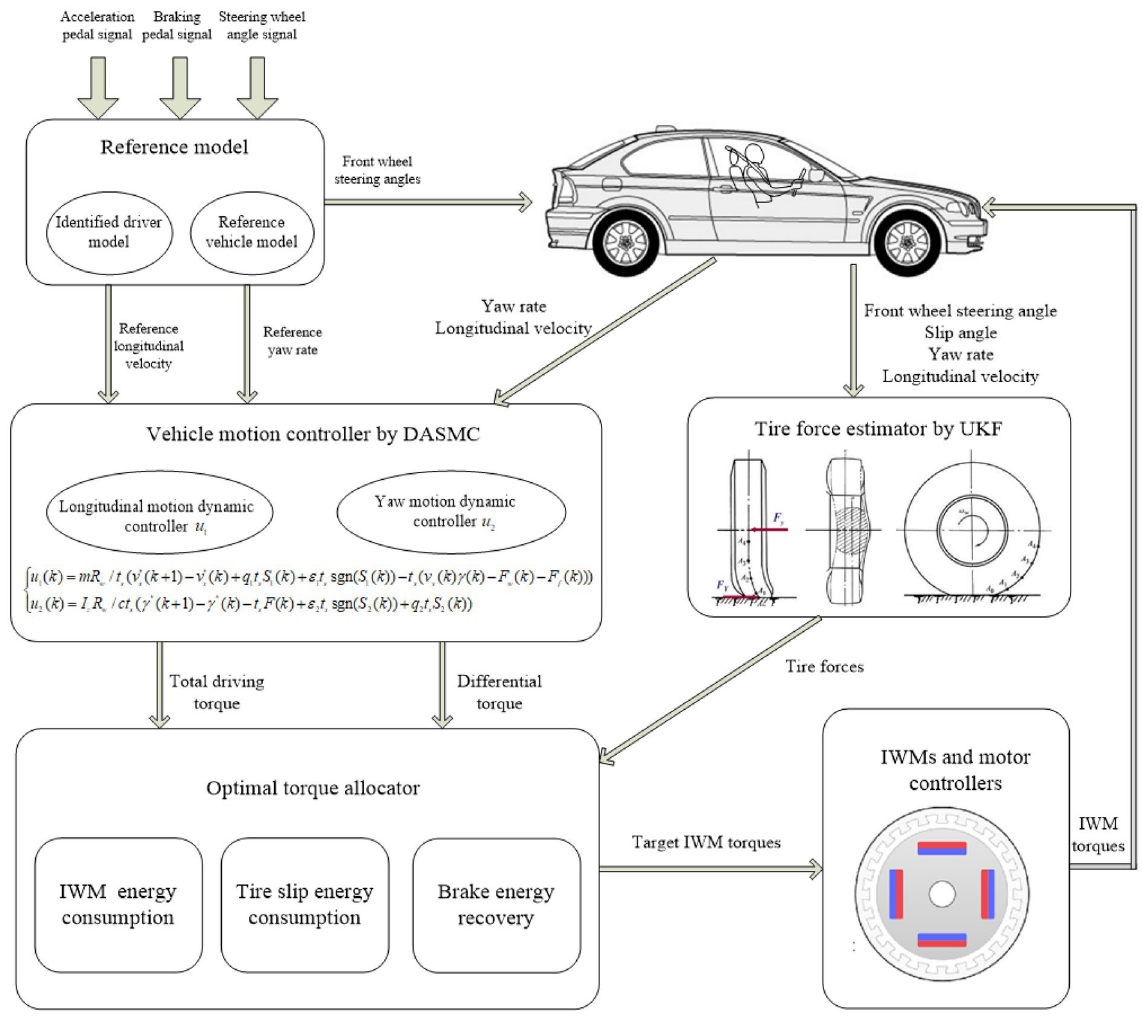
Figure 1 Energy efficient control strategy for EV driven by IWMs based on DASMC